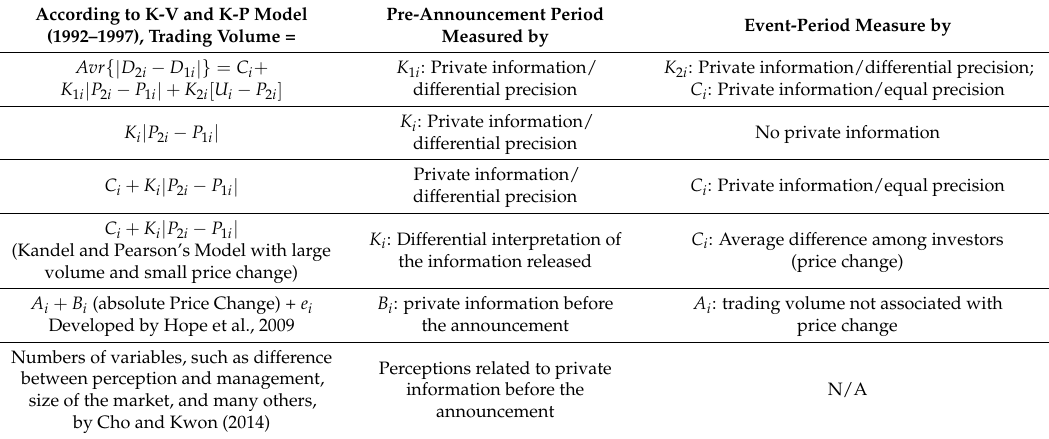
Table 1. Summary of the relationship between Trading volume and Price